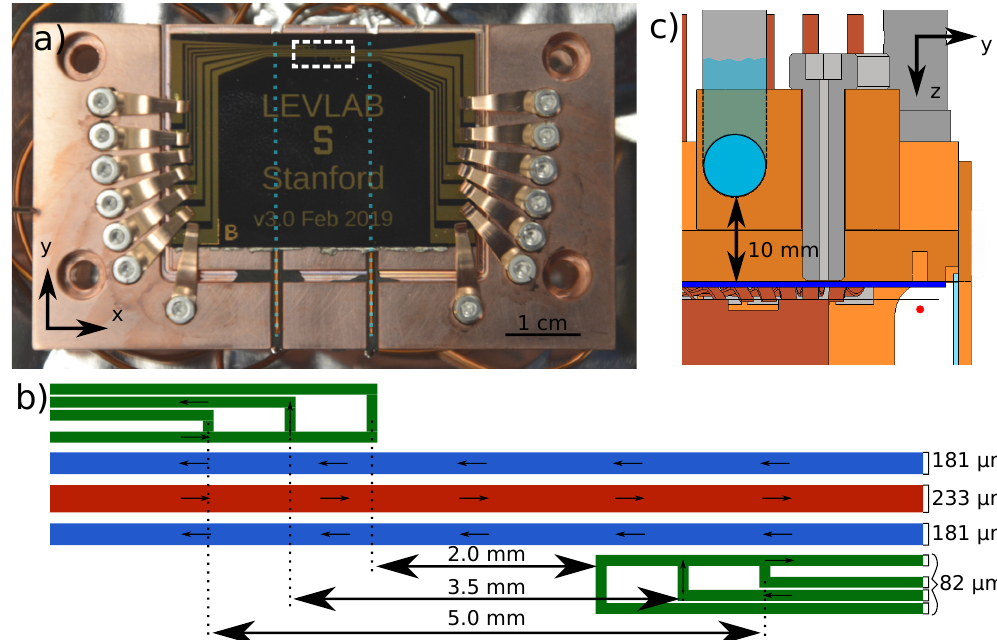
Figure 4: The atom chip. (a) Photograph of the mounted atom chip. The locations of additional longitudinal trapping wires located 1 mm behind the atom chip are indicated by dotted blue lines. (b) A sketch of the region outlined by the dashed box in panel (a) shows the wire portions that contribute most to the atom trapping. Current directions during measurement are as indicated. (c) Cross-sectional view showing the atom chip cooling apparatus. A reservoir (light blue) occupies a space 10 mm above the chip (dark blue) and is filled with liquid nitrogen or chilled water to cool both the atom chip and radiation shield. The distance between atom chip, sample chip, and atomic gas is exaggerated for clarity. The sample substrate is in black (a thin line, as seen on edge), the atom chip is in dark blue, the electrical contacts are in dark brown, the BEC position below the sample substrate chip is indicated by a red dot, and the viewport window for high-NA imaging is indicated by the light blue, thin vertical